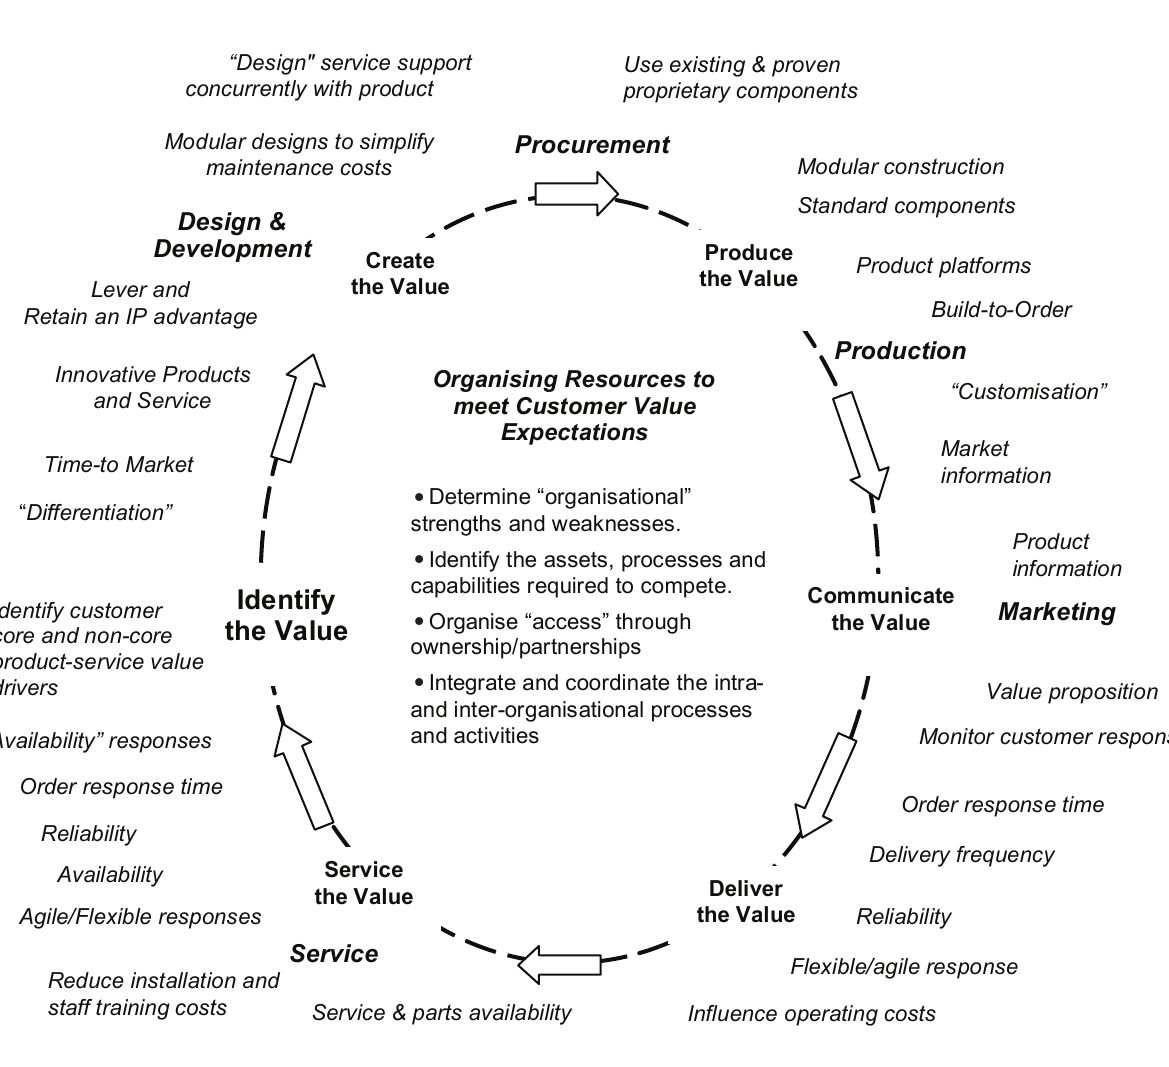
Figure 4: Identifying important customer-facing processes that add customer value